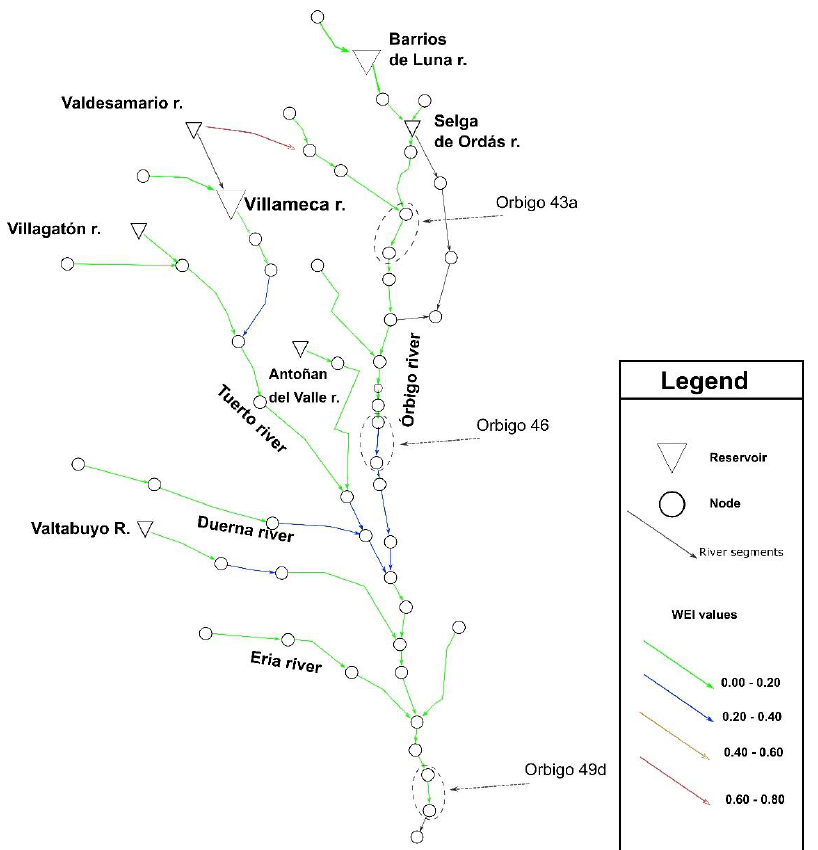
Figure 4. Plan view of the water exploitation index (WEI + ) in each river stretch based on the entire simulated period. Figure 5 depicts the minimum, mean and maximum values of the yearly WEI + along the two river paths indicated in Figure 1. In the first river path, the mean values of the yearly WEI + along the middle and lower parts of the basin are higher than in the upper basin, but the mean values along path 1 are always less than 0.25. However, in some years the WEI+ values are much greater, reaching maximum values above 0.47.